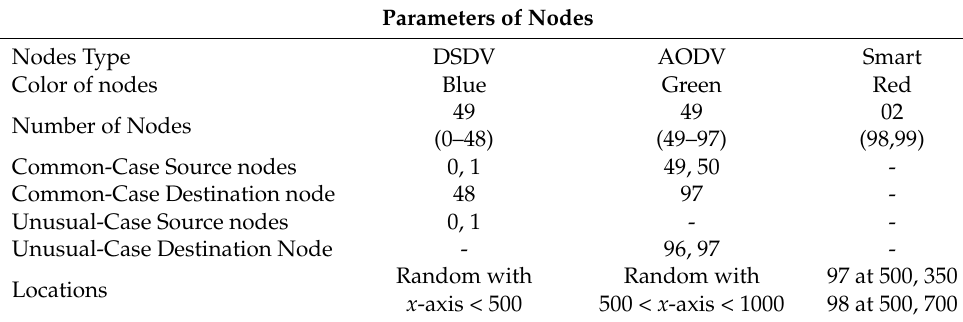
Table 9. Case 1: Parameters for classes of